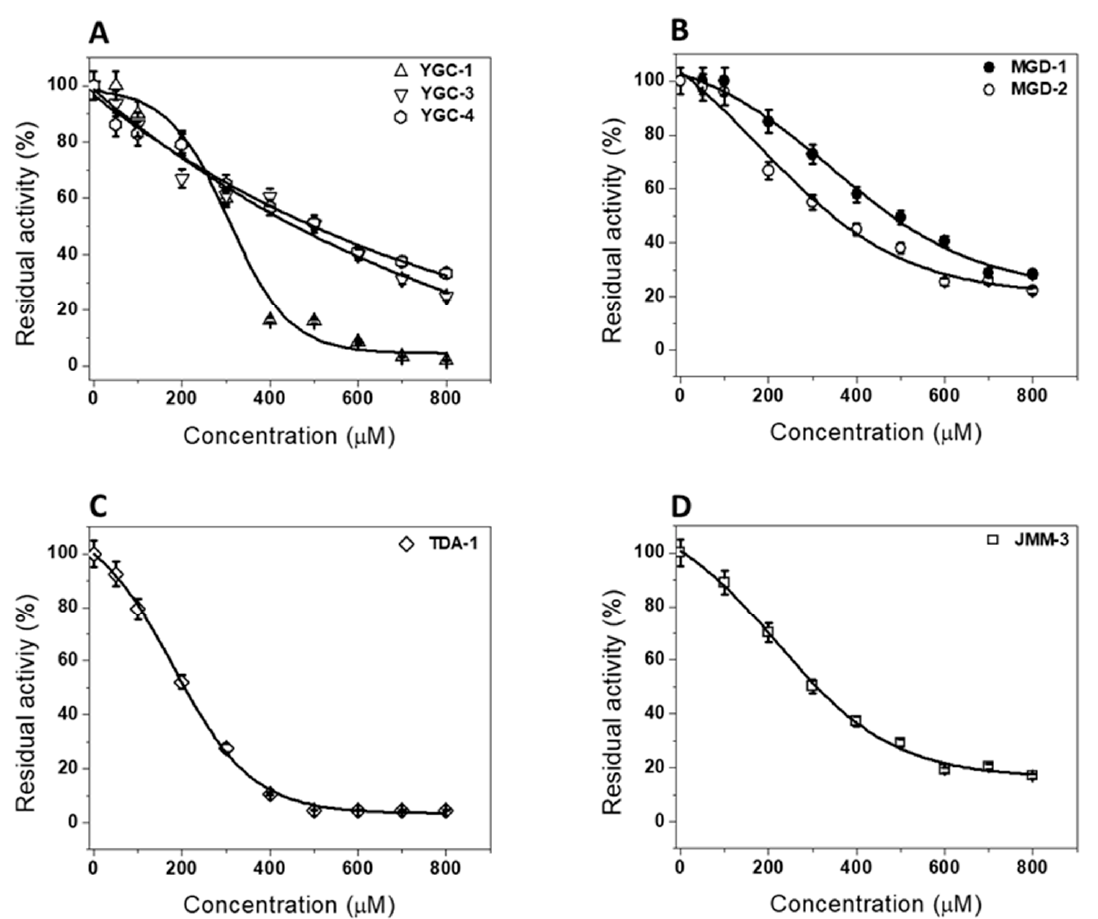
Figure 3. Inactivation assays of the HpG6PD enzyme with chemical compounds. The HpG6PD protein was adjusted at a final concentration of 200 µ g/mL and incubated with increasing concentrations of the ( A ) YGC family; ( B ) MGD family; ( C ) TDA-1 compound; and ( D ) JMM-3 compound. The residual activity was determined after 2 h of incubation at 37 ◦ C. The figure shows representative experiments performed in triplicate. The values represent the mean ± standard deviation from three independent experiments, and standard errors were lower than 5%.